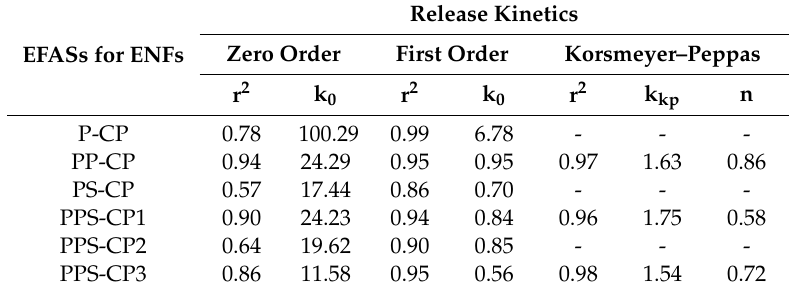
Table 4. Release kinetics parameters from di ff erent kinetic models.